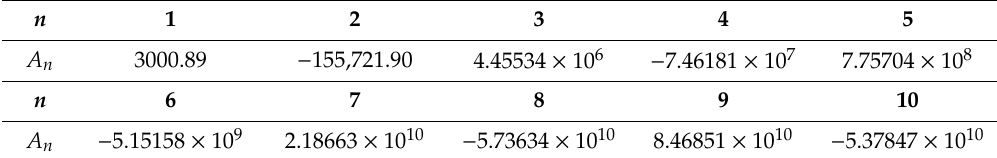
Table 5. Coe ffi cient value A n (MPa) of the shape function f ( ε )